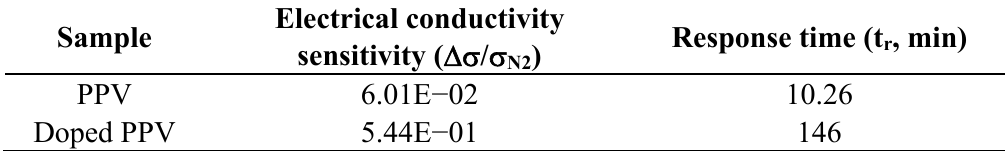
Table 2. Electrical conductivity sensitivities and temporal responses of PPV and doped PPV towards